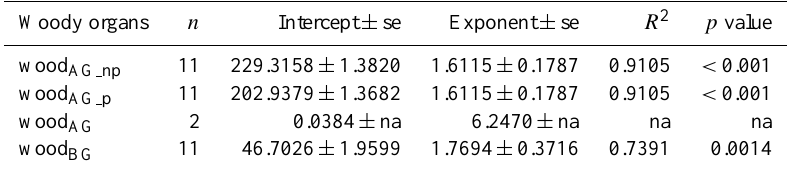
Table 1. Coefficients of the power allometric equation found for aboveground woody biomass (wood AG ) and belowground woody biomass (wood BG ) . The “wood AG ” equation is calculated using the “pruned aboveground woody biomass” equation (wood AG p ) at the beginning of the season and the “not-pruned aboveground woody biomass” equation at the end of the season (wood AG np ) , thus accounting for the pruning material. Reported are parameters with their relative standard